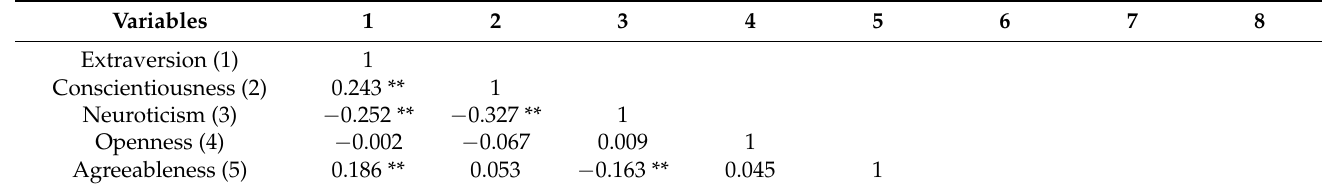
Table 3. Correlations for the study